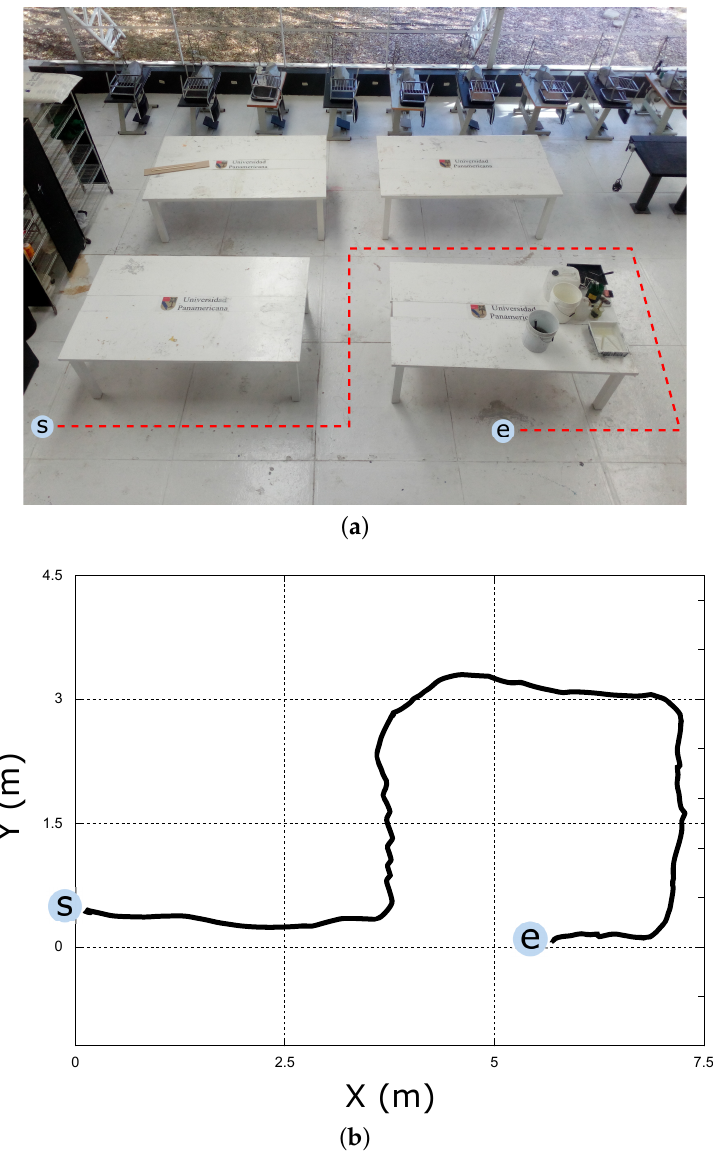
Figure 11. Navigation experiment: ( a ) The structured environment (i.e., static objects) and the trajectory proposed to the subject; s and e stand for the starting and end points, respectively. ( b ) Actual trajectory performed with a set of 10 navigational instructions: go forward, turn left, go forward, turn right, go forward, turn right, go forward, turn right, go forward, and